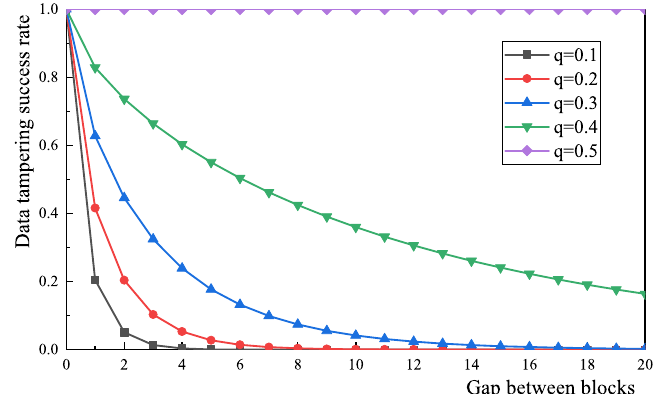
Figure 2. Data tampering success rate characteristics for the